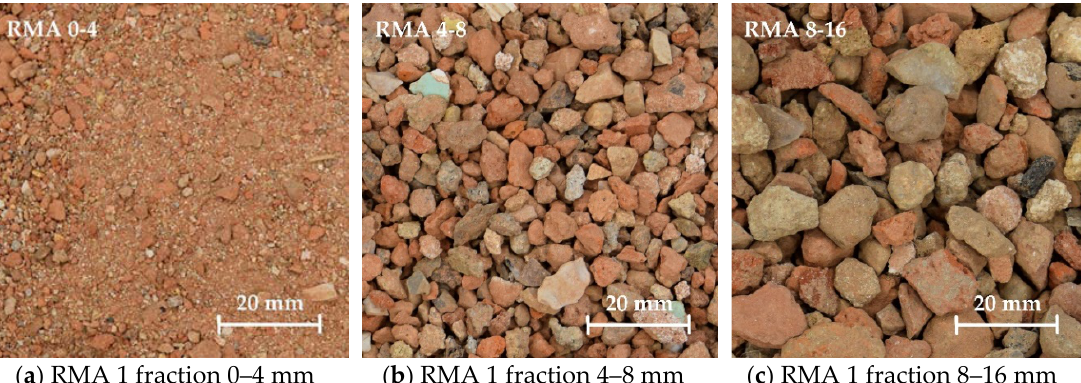
Figure 1. Recycled masonry aggregate (RMA 1).